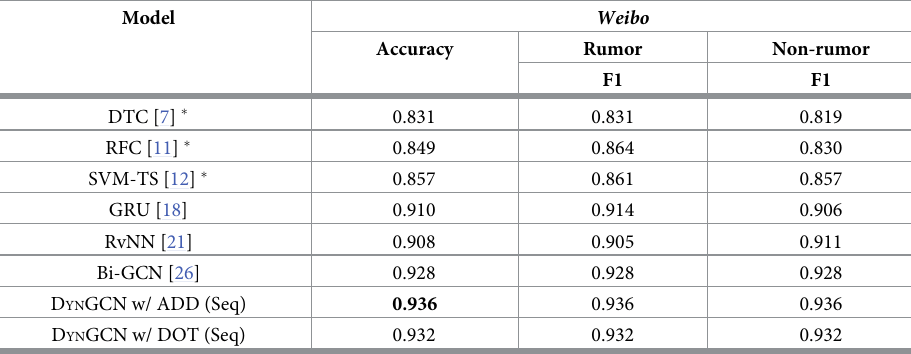
Table 3. Overall performance of rumor detection task on Weibo